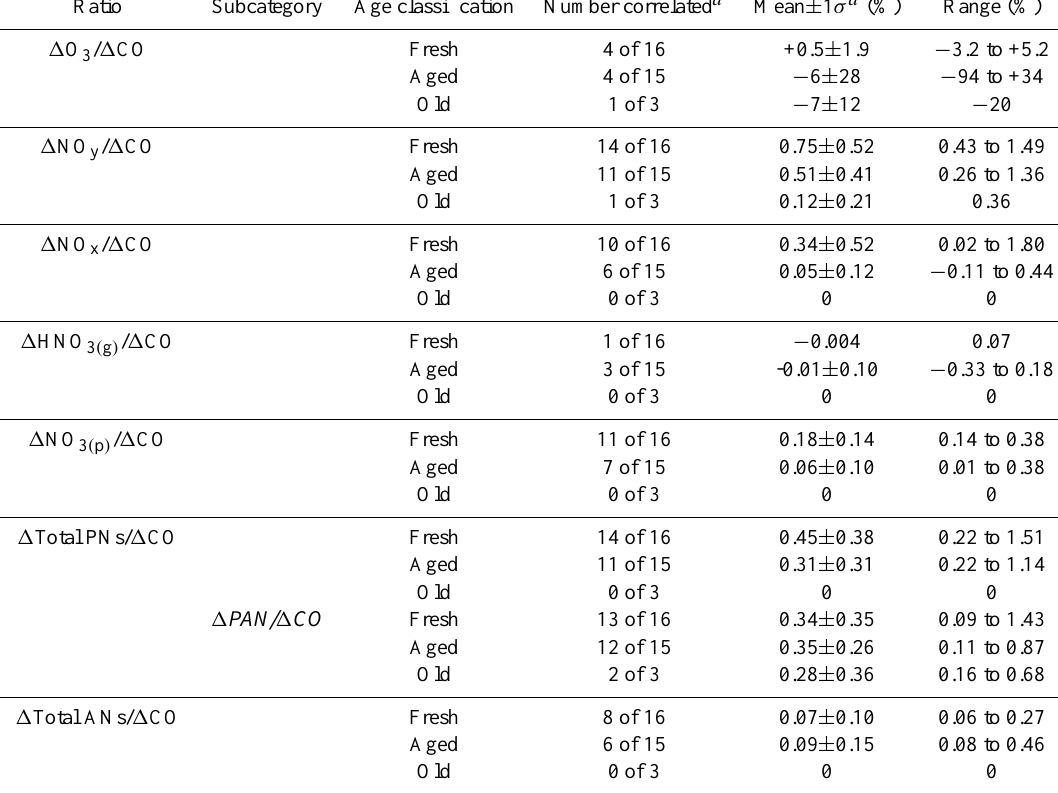
Table 4. Enhancement ratios (mol/mol) for boreal plumes observed by NASA DC8 during ARCTAS.